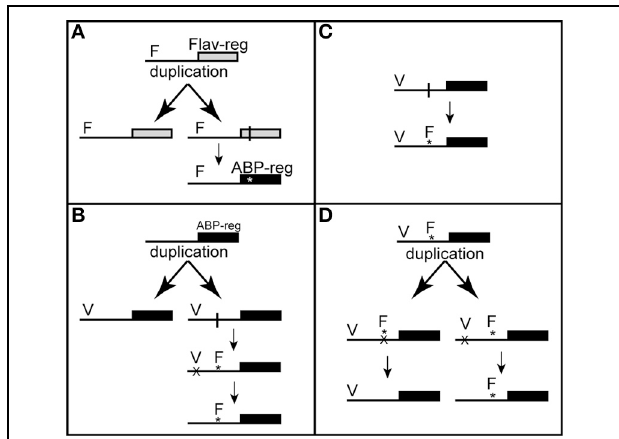
FIGURE 2 | Pathways of co-option leading to gains in floral anthocyanins. Solid boxes represent coding regions of R2R3-MYB transcription factors, and horizontal lines represent their cis- regulatory elements. Within these regions, “F” denotes a floral cis -regulatory element, while “V” indicates a vegetative element. Vertical lines denote mutation locations and asterisks the resulting substitution. An “X” indicates a loss of function mutation. (A) Gene duplication followed by co-option via neofunctionalization. An R2R3-MYB that regulates some other product in flowers (such as flavonoids) duplicates. A coding mutation in the DNA binding domain of one copy results in a transition to ABP regulation. (B) Gene duplication followed by co-option and specialization. Duplication of an R2R3-MYB that regulates vegetative anthocyanins acquires a cis -regulatory mutation in one copy that introduces a floral specific element. Specialization occurs if the copy with the floral cis -element loses its vegetative expression. (C) Co-option occurs without gene duplication when a mutation introduces a floral cis -element into a pre-existing R2R3-MYB that regulates vegetative anthocyanins. (D) Co-option of a pre-existing R2R3-MYB followed by gene duplication. After the co-option of the ABP for floral anthocyanins, vegetative and floral anthocyanins are favored differently by selection. In these cases, gene duplication may be advantageous to reduce this constraint. Post duplication deletions of the alternate cis- elements then produce